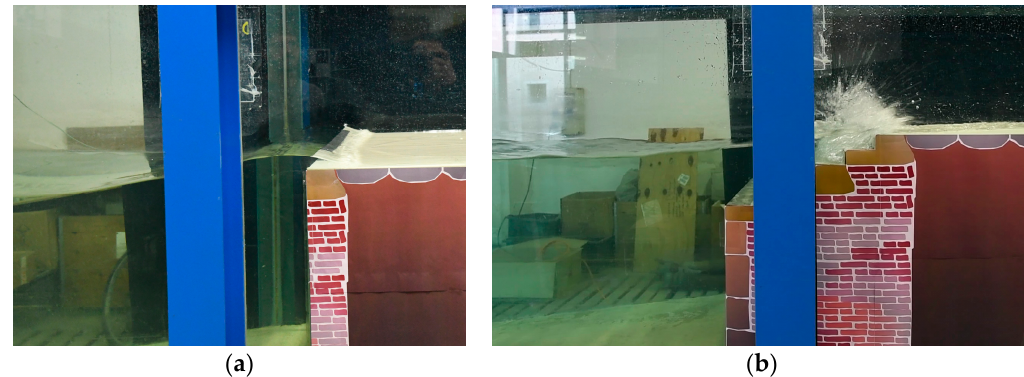
Figure 9. Snapshot of the same wave approaching two different cross-sections: type B ( a ), type C ( b ).